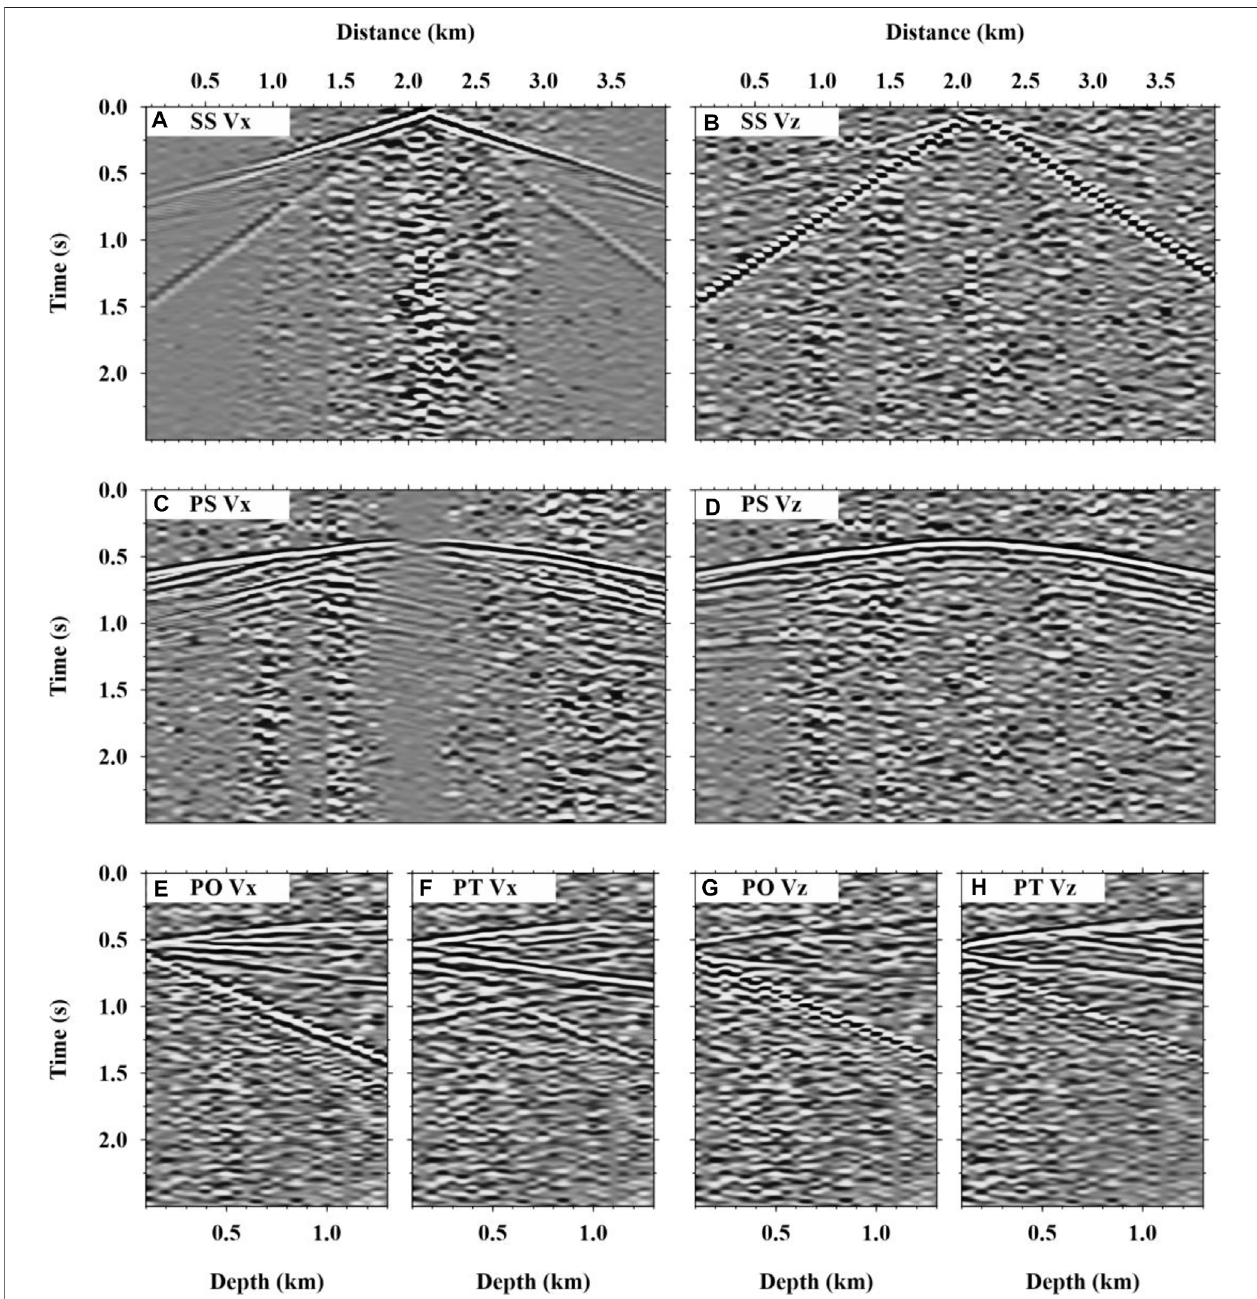
FIGURE12 | Noisy datawith S/N =2.0 synthesized by adding fi eld noiseto theVx and Vz seismograms ofSS (Plots A and B ), PS(Plots C and D ),PO(Plots E and G ), and PT (Plots F and H ), as shown in Figure 2 . The seismograms of PT are recorded using the array on the vertical well on the right-hand side of the model.